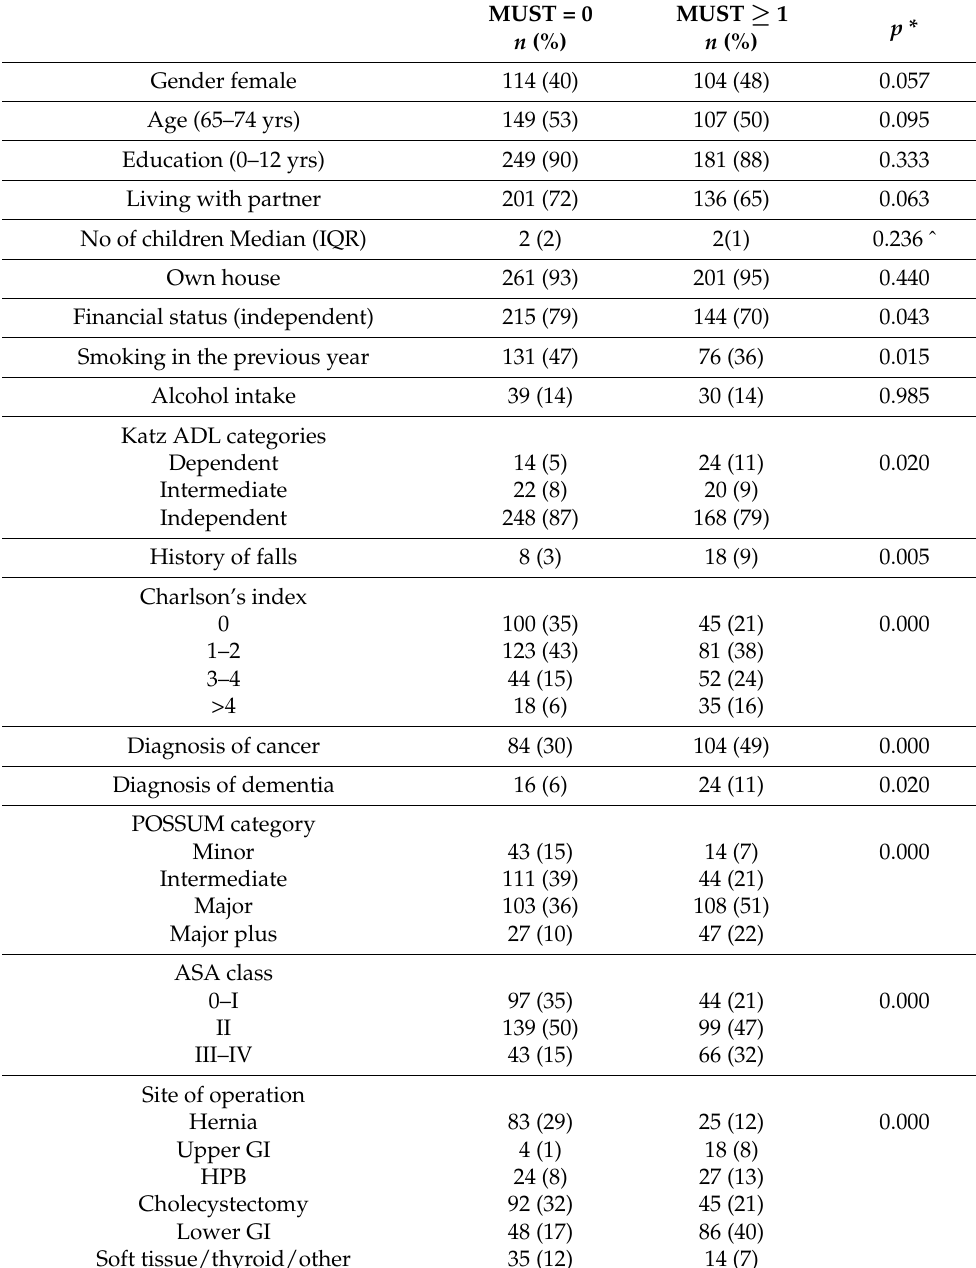
Table 1. Preoperative factors associated with malnutrition risk in older patients undergoing gen- eral